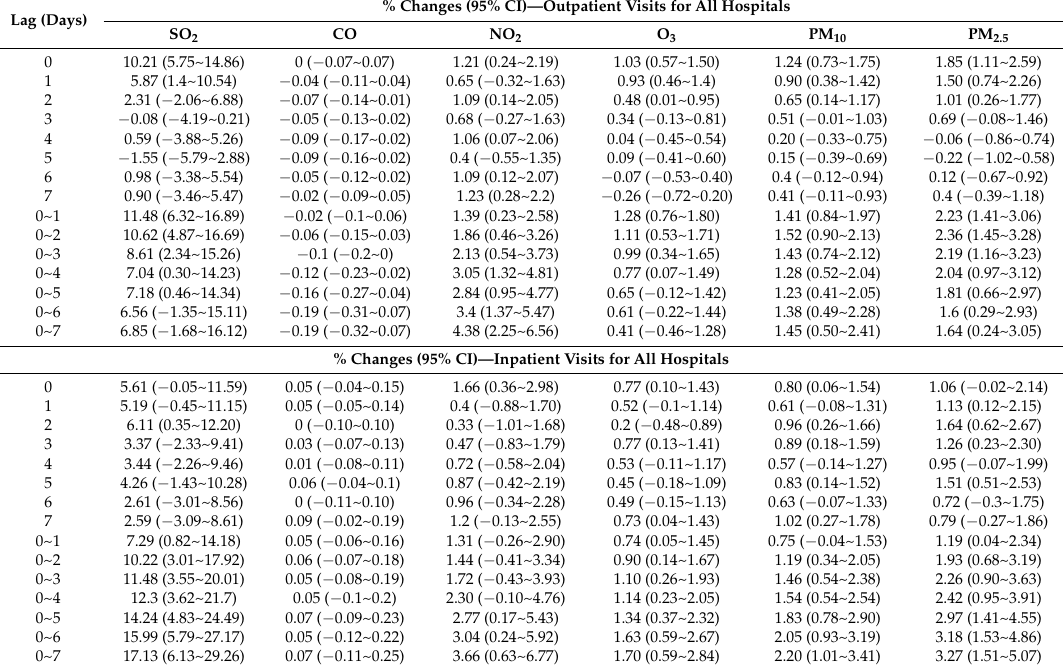
Table 2. Increased risk and 95% confidence intervals for per 10 µ g/m 3 increase in air pollutants for associations between air pollutants and outpatient and inpatient